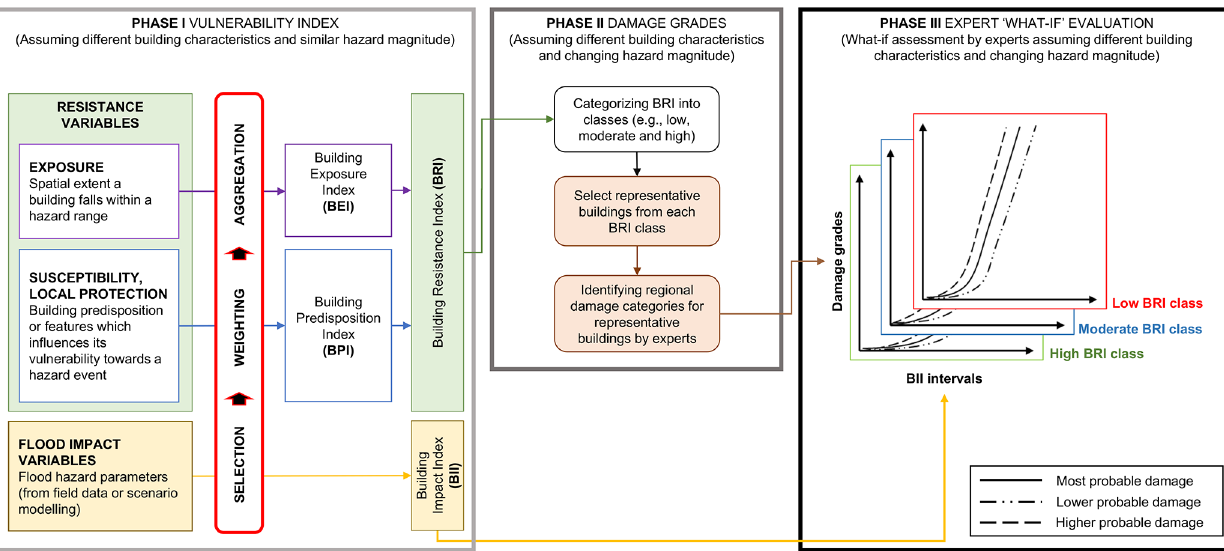
Figure 3. The proposed conceptual framework, linking vulnerability indicators to damage grades so that vulnerability to the built environment can be better assessed in data-scarce regions. The framework consists of three consecutive steps (phases) from the vulnerability index development (assuming different building characteristics but similar hazard magnitudes) to the damage grades (assuming different building characteristics and changing hazard magnitudes) and finally an expert-based “what-if”-evaluation, leading to functions linking damage grades from phase II to building impact indices (BIIs) from phase I for each BRI